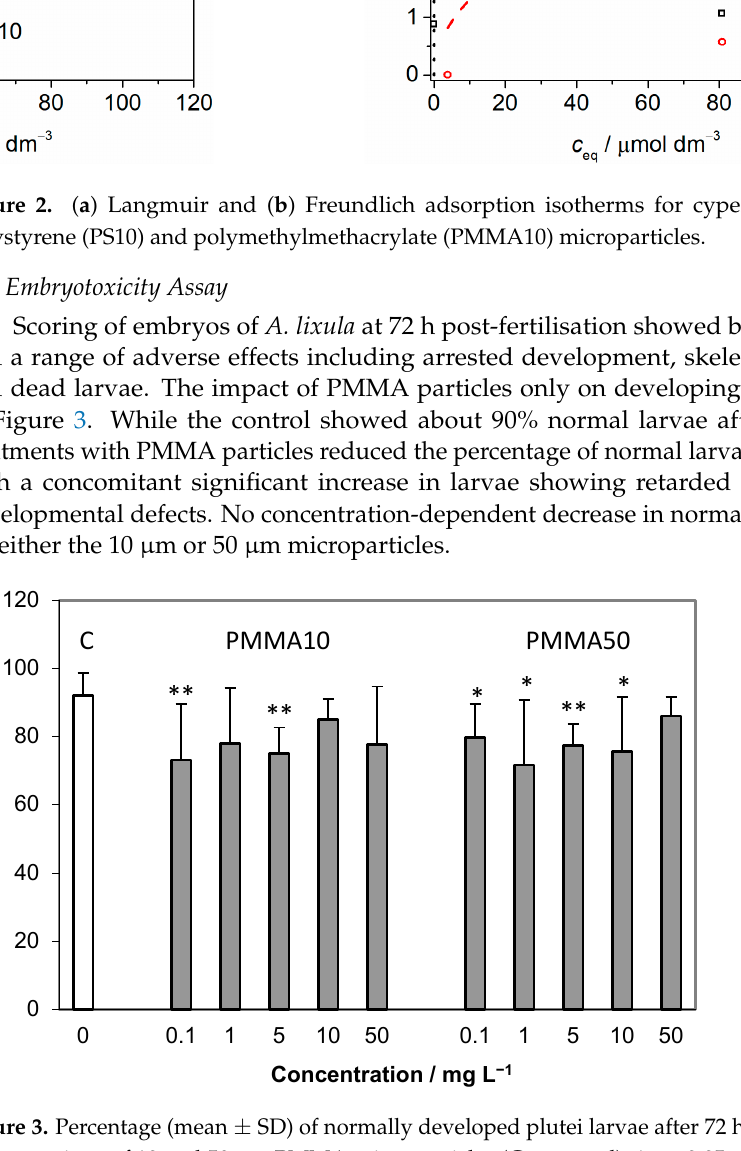
Figure 3. Percentage (mean ± SD) of normally developed plutei larvae after 72 h exposure to vari- ous concentrations of 10 and 50 μ m PMMA microparticles (C—control). * p < 0.05, ** p < 0.01.